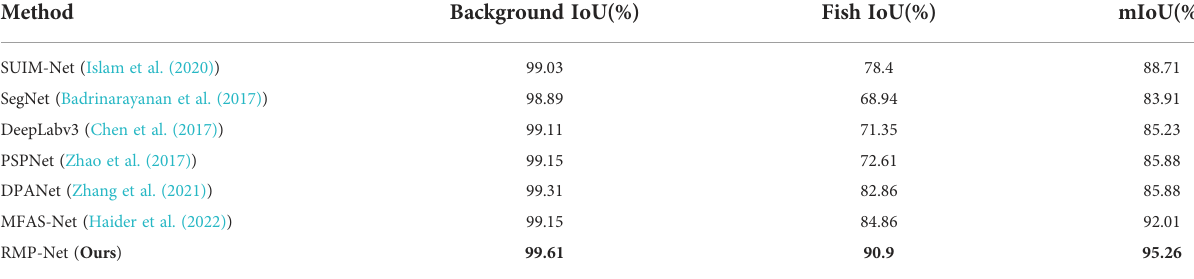
TABLE 7 Comparing our proposed method with state-of-the-art methods on the DeepFish dataset.